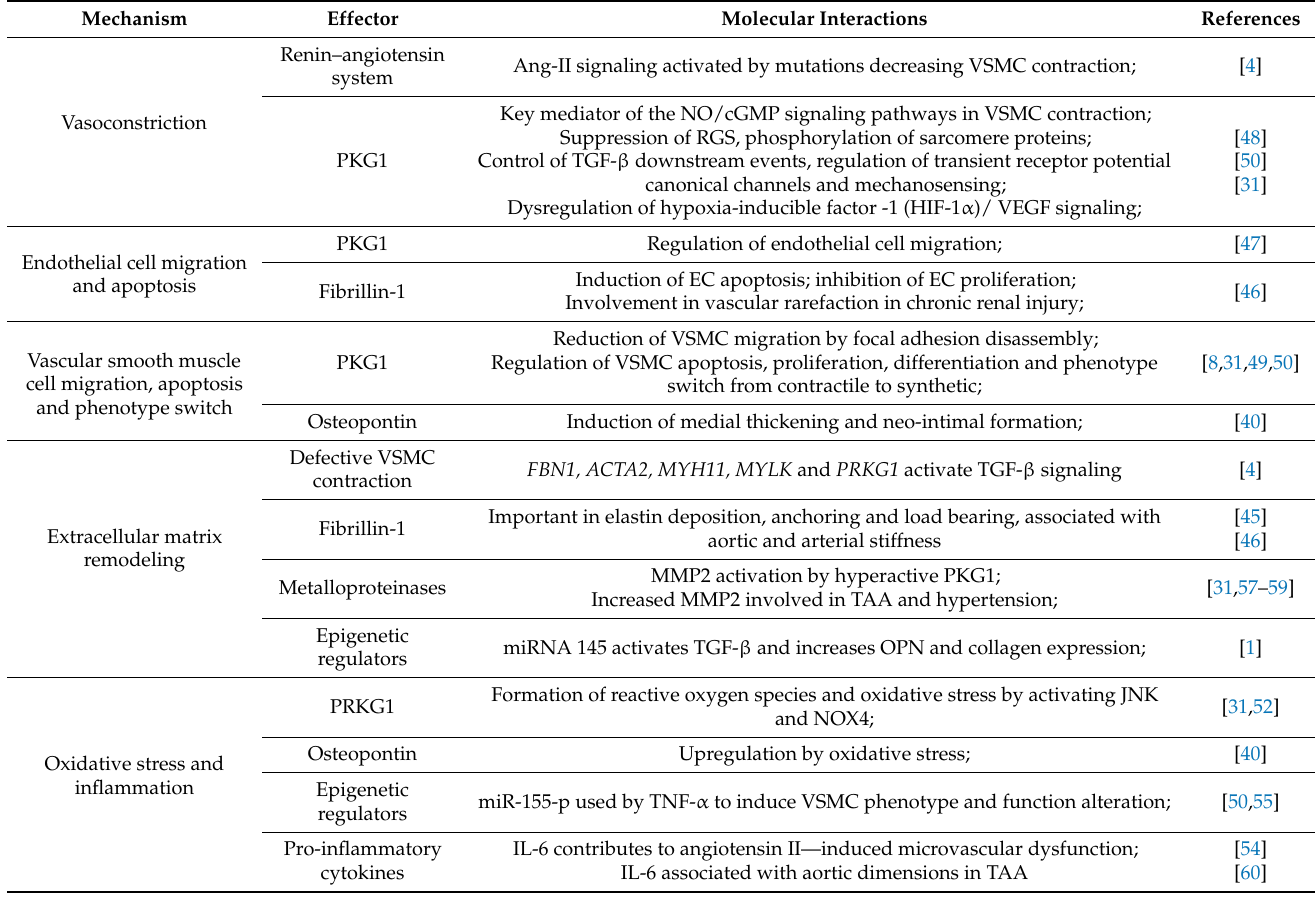
Table 2. Possible mechanisms associated with hypertension in thoracic aortic